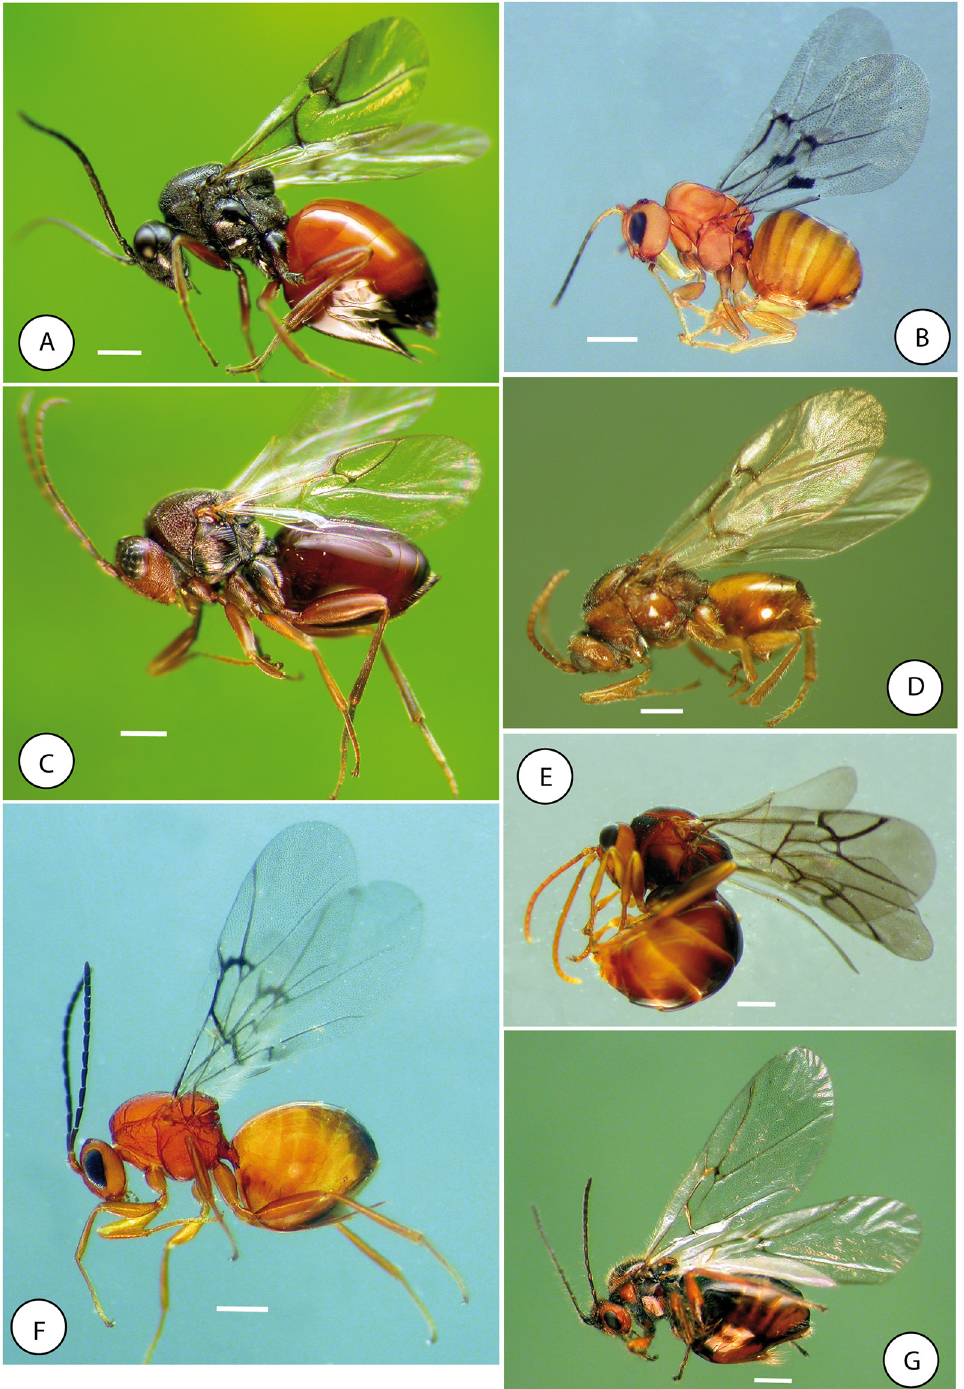
Fig 18. Habitus of exemplar species of tribes of Cynipidae. A) Diplolepis mayri (Schlechtendal) (Diplolepidini). B) Eschatocerus acaciae (Eschatocerini). C) Synergus umbraculus (Olivier) (Synergini sensu stricto). D) Pediaspis aceris (Pediaspidini). E) Qwaqwaia scolopiae (Qwaqwaiini). F) Plagiotrochus australis (Mayr) (Cynipini) and G) Cynips disticha Hartig (Cynipini). Scale bar 0.5 mm.